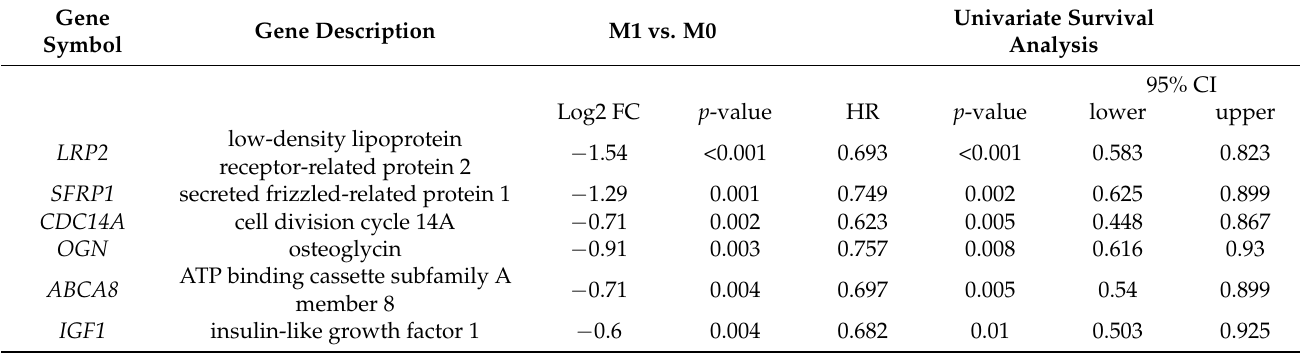
Figure 3. A total of 19 DEGs are differentially expressed in M1 and associated with survival. ( a ) Volcano plot of differentially expressed genes (DEGs). Cutoffs: p -value = 0.05, log2 FC = 0.586. Due to limited space THBS4, PTGER3, SFRP4, HSPA2, and ZBTB16 are not labeled. ( b ) Heatmap of DMFS-related 19 DEGs. ( c ) Prognostic value of the 19 DEG signature utilizing various independent datasets available in the Kaplan–Meier Plotter tool. ( d ) Kyoto Encyclopedia of Genes and Genomes (KEGG analysis of DMFS-related 19 DEGs. ( e ) Gene Ontology (GO) analysis of DMFS-related 19 DEGs. Table 2. Differentially expressed genes (LIMMA test) and survival associations thereof (univariate analysis; calculated with Cox regression